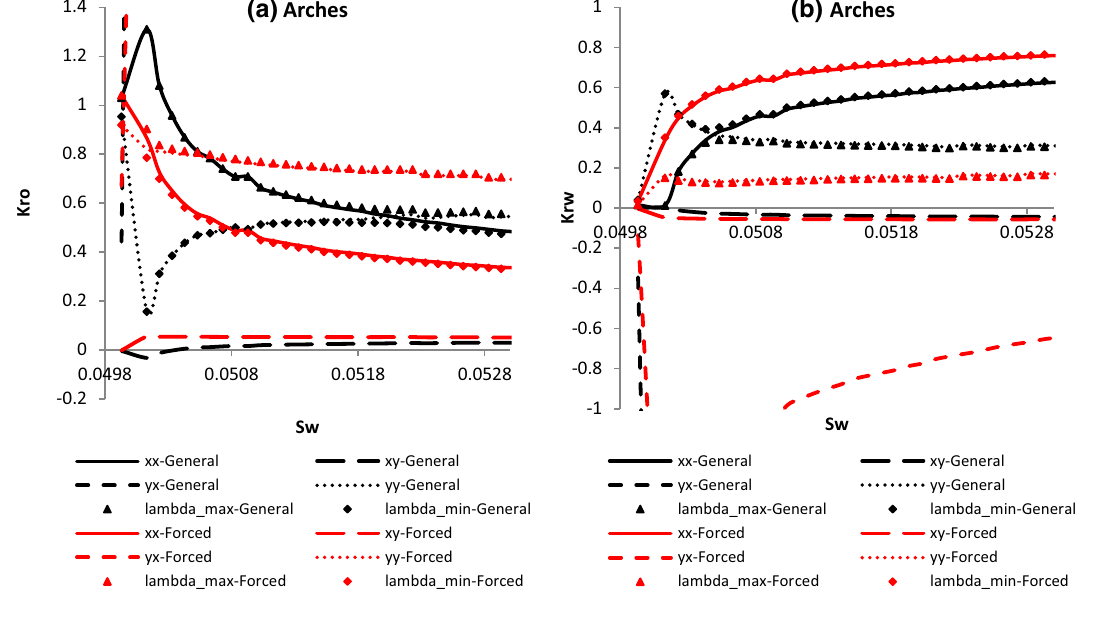
Fig. 5 Relative permeability tensor components for oil ( a ) and water ( b